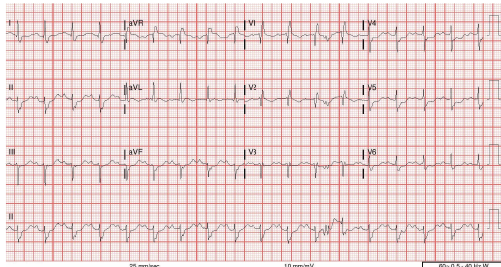
Figure 2: EKG showing sinus rhythm with right bundle branch block,leftanteriorfascicularblock,andnonspecificST-Twavechan- ges.